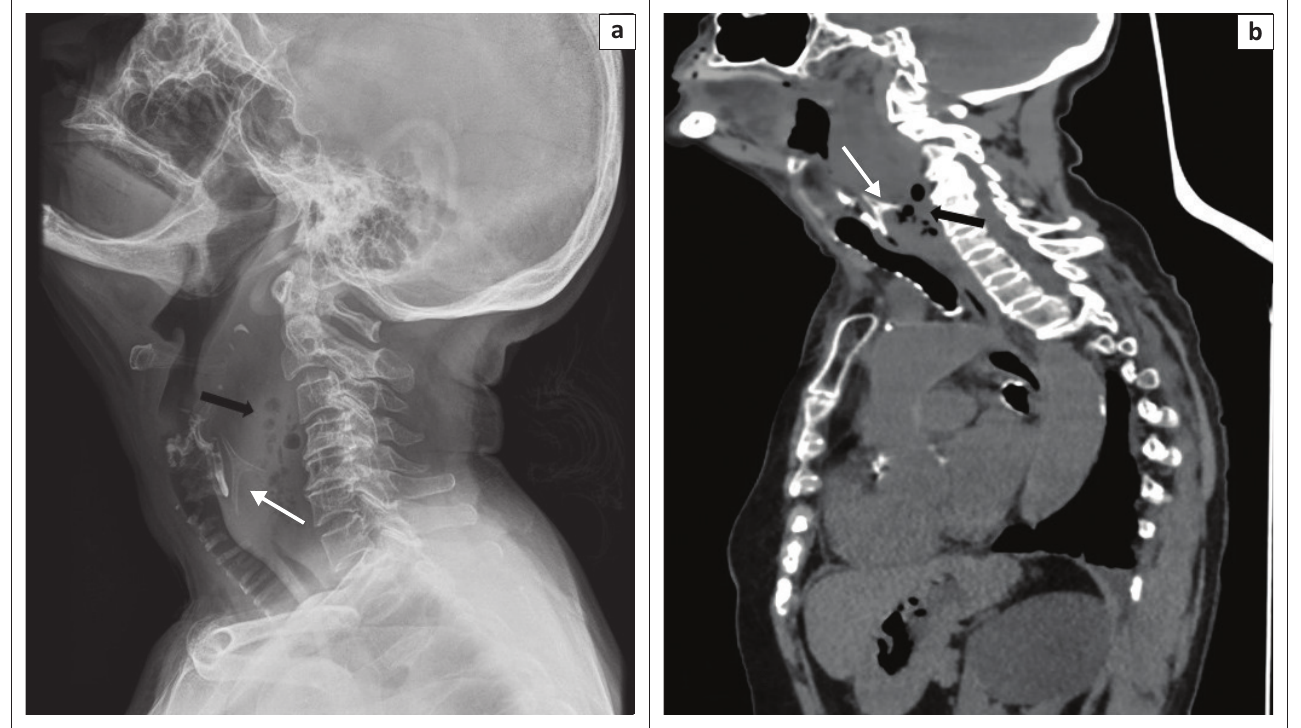
FIGURE 5: (a) Lateral radiograph of the neck shows a ‘Y’ shaped chicken bone (thin arrow) impacted in the posterior wall of the cricopharynx, along with prevertebral soft tissue thickening demonstrating multiple air locules (thick arrow). (b) Computed tomography sagittal reformatted image confirmed the chicken bone (thin arrow) location and the retropharyngeal